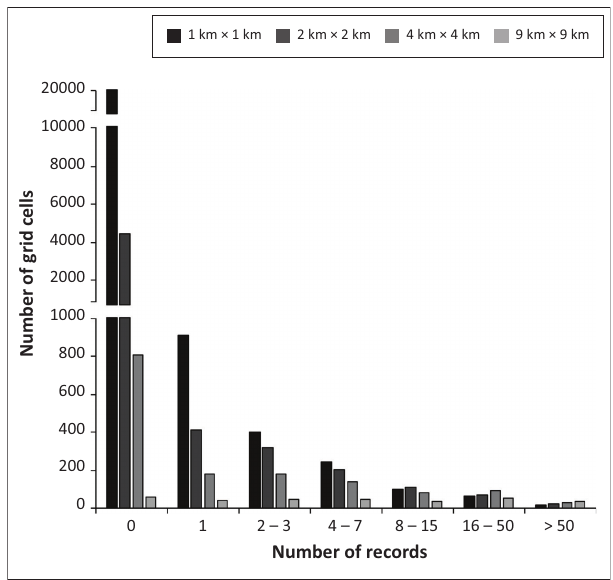
FIGURE 3: Frequency distributions of the numbers of Kruger National Park reptile occurrence records per grid cell at 1 km × 1 km, 2 km × 2 km, 4 km × 4 km and 9 km × 9 km resolutions.